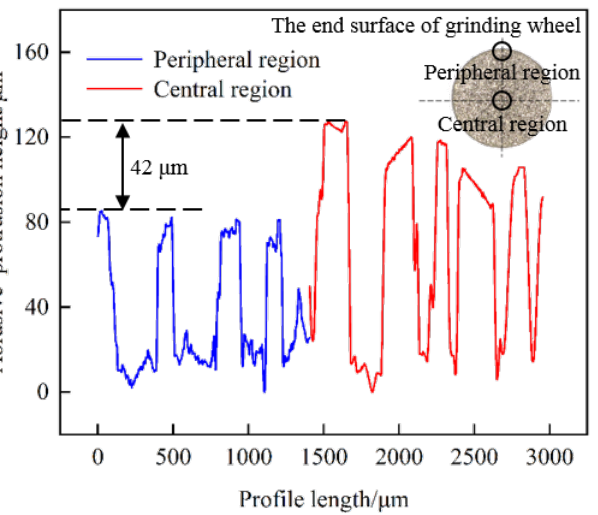
Figure 9. Comparison of abrasive grits’ protrusion height of the dressed grinding wheel in the peripheral region and center region.